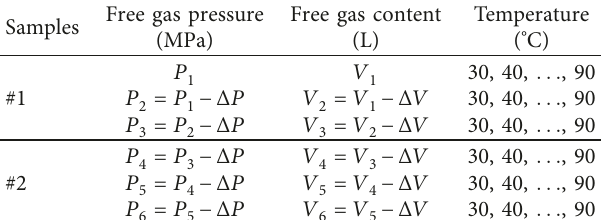
Table 2: The test scheme.